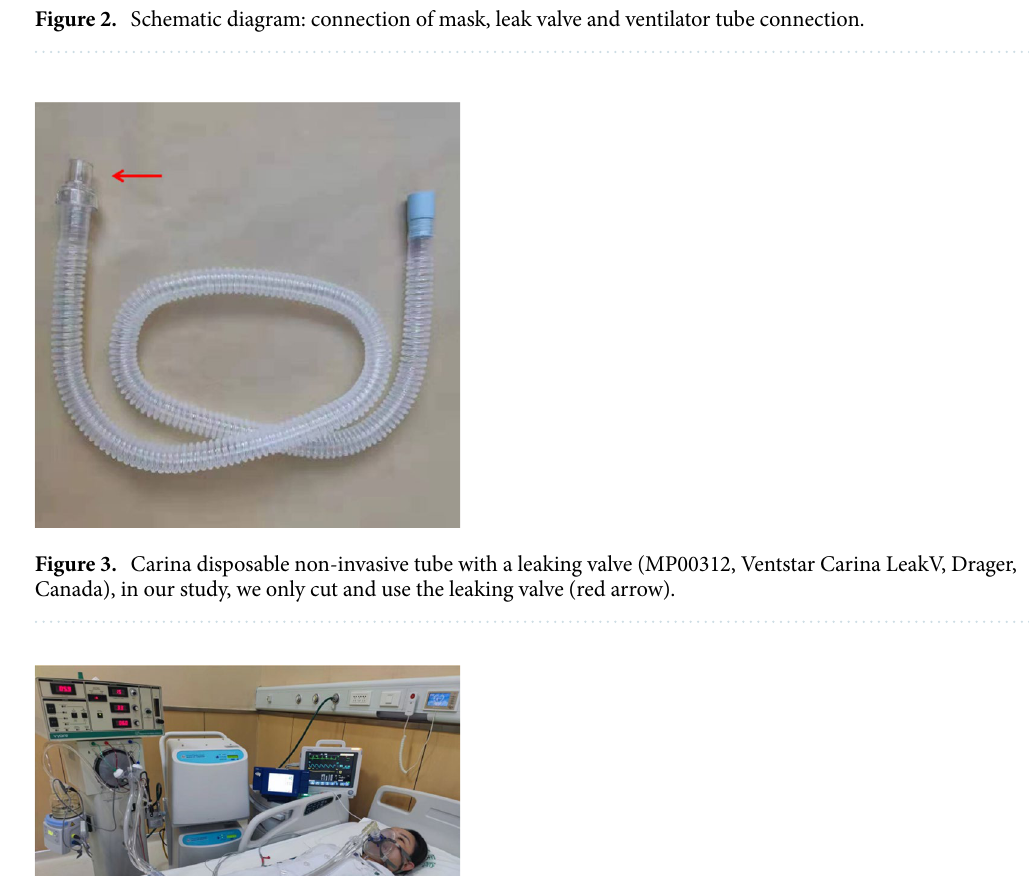
Figure 2. Schematic diagram: connection of mask, leak valve and ventilator tube connection.